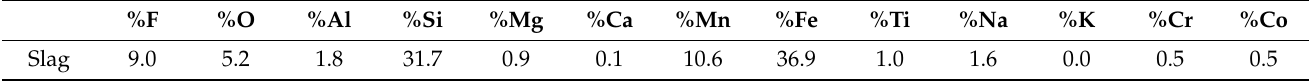
Figure 6. ( a ) BSE image at 582× magnification showing a 3D needle structure within the slag dome in the MP9 post ‐ weld slag; ( b ) BSE image at 2710× magnification of the 3D structure marked in Figure 6a; and ( c ) EDX maps of 3D slag structures in ( b ). Table 8. Average EDS analyses of 3D slag structures in Figure 6b.